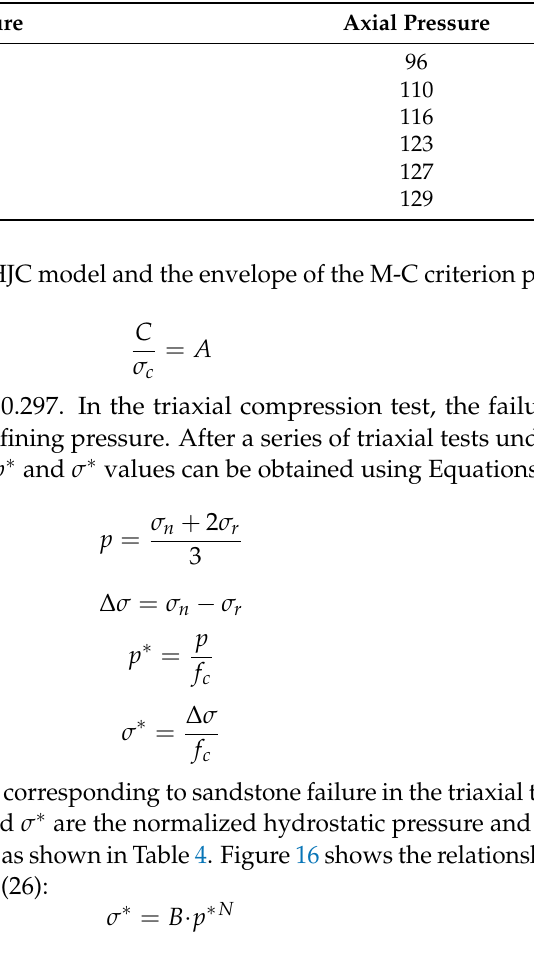
Table 4. The values of p , ∆ σ , p ∗ and σ ∗ under different confining pressures. p ∆ σ p * σ *